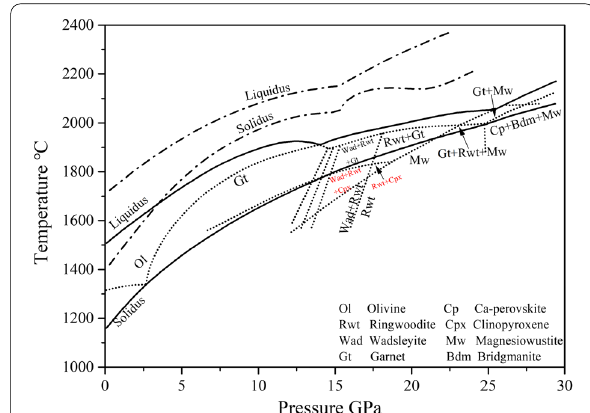
Fig. 10 A simplified P–T diagram for the Allende meteorite (solid lines) after Agee et al. (1995) and Asahara et al. (2004), and the P–T diagram for the peridotite (dot-dash lines) from Zhang and Herzberg (1994) and Trønnes and Frost